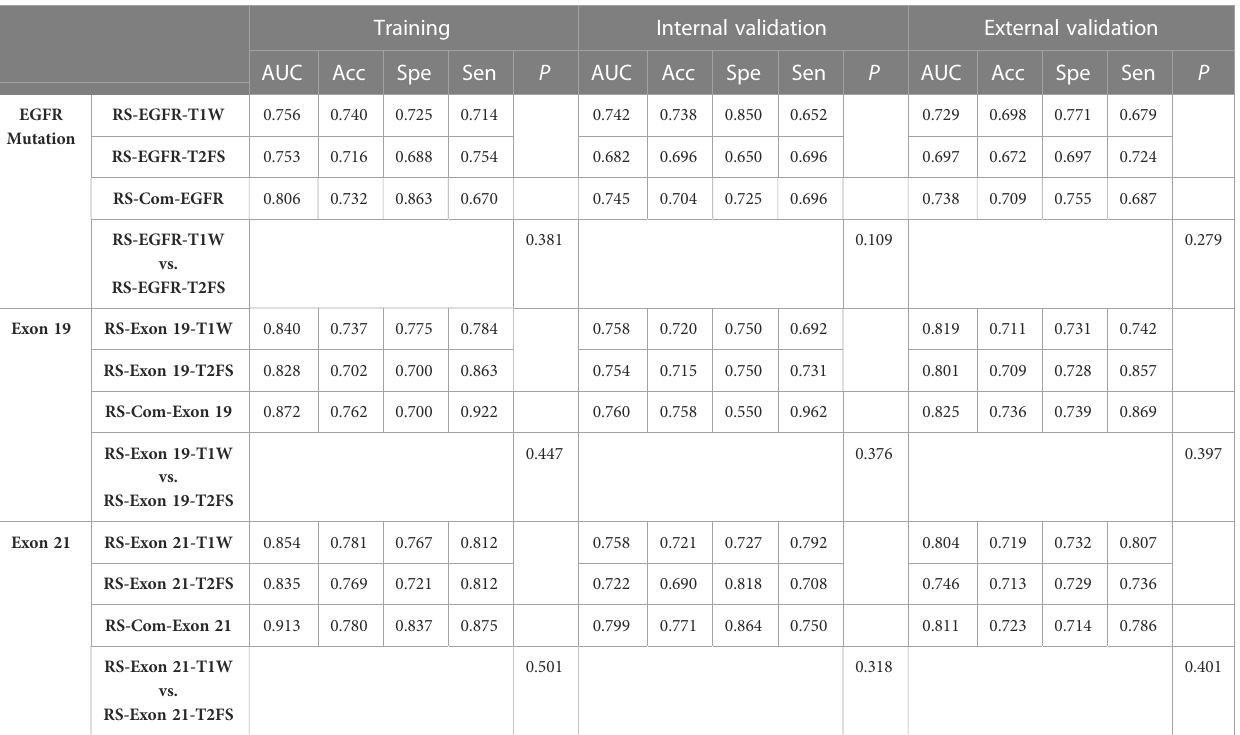
TABLE 2 Comparisons of the developed RSs for detecting the EGFR mutation and